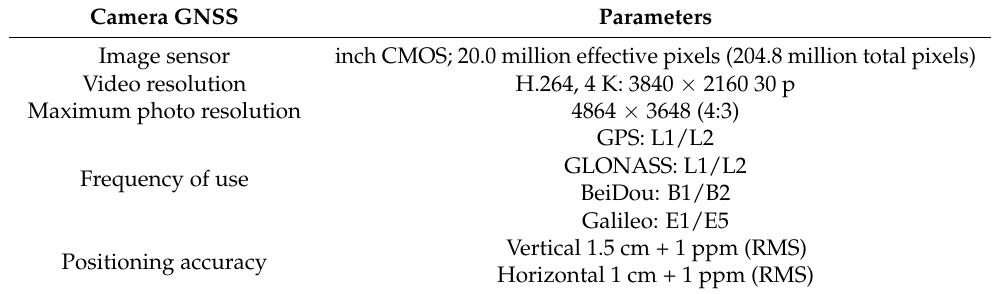
Table 1. UAV parameters.